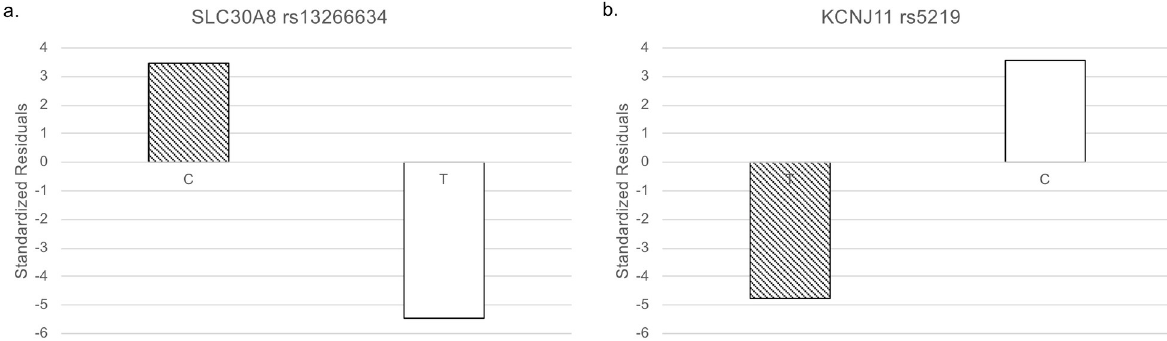
Fig 2. Standardized residuals of alleles. White: non-risk allele and diagonal stripes: risk allele. (a) SLC30A8 rs13266634. (b) KCNJ11 rs5219.